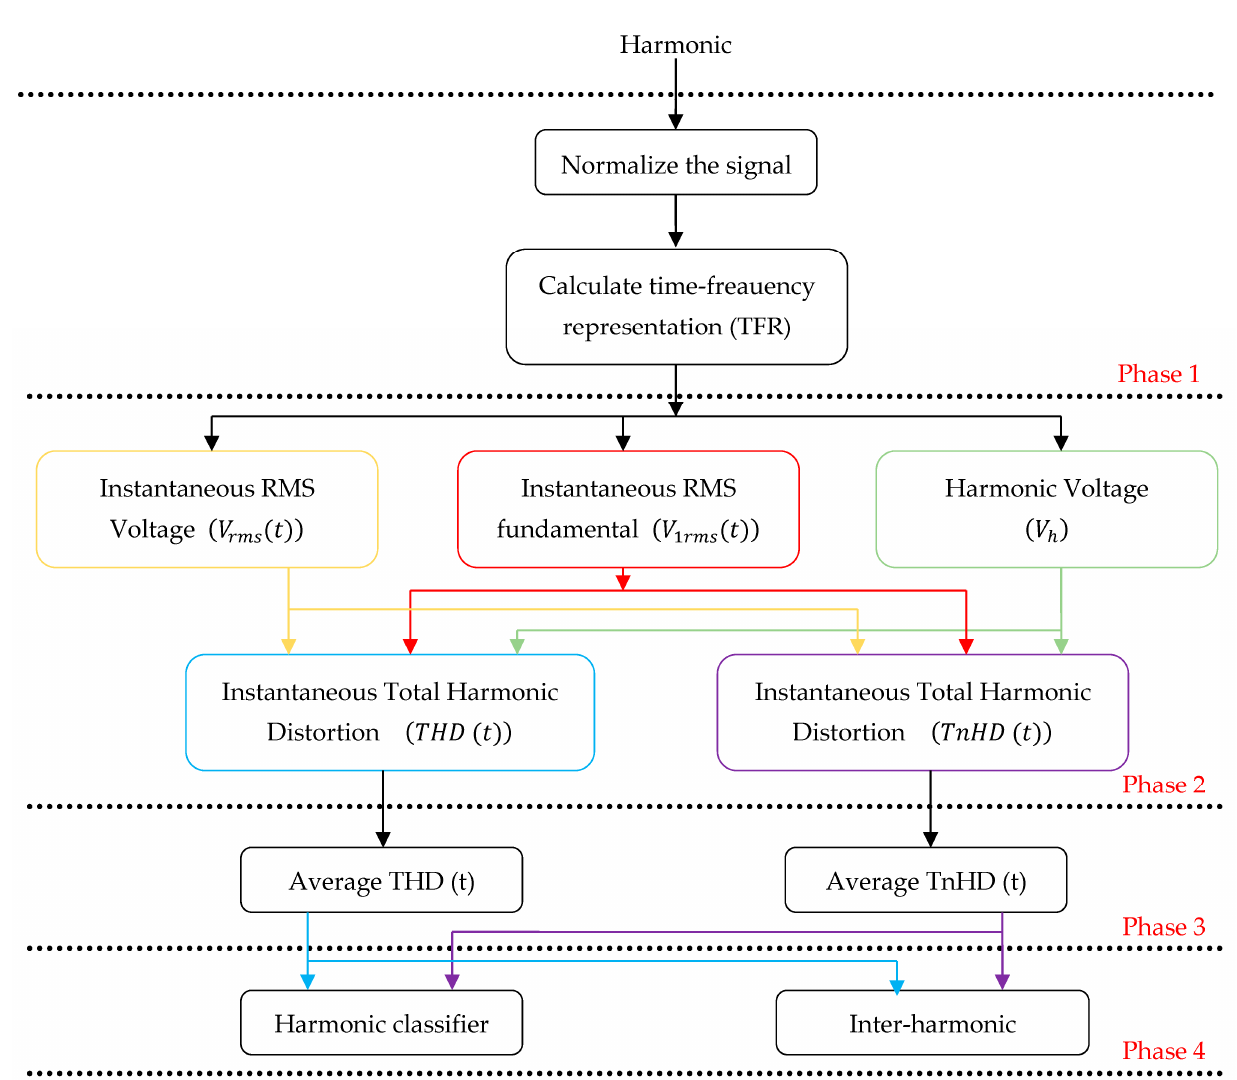
Figure 3. Flow chart of harmonic signal detection and